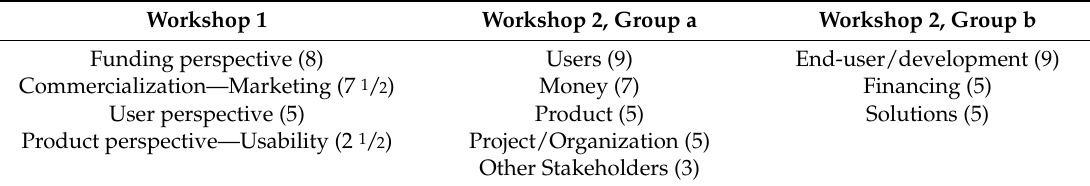
Table 1. Categories from the workshops. The number of issues for each category is displayed in parentheses afterwards. Note that in workshop 1, one issue was in two different categories, thus the 1 / 2 .